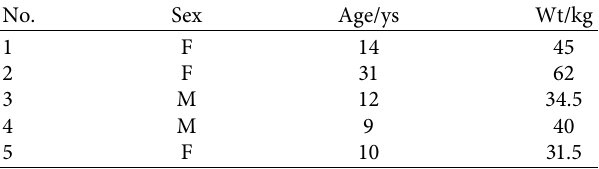
Table 1: Characteristics of the